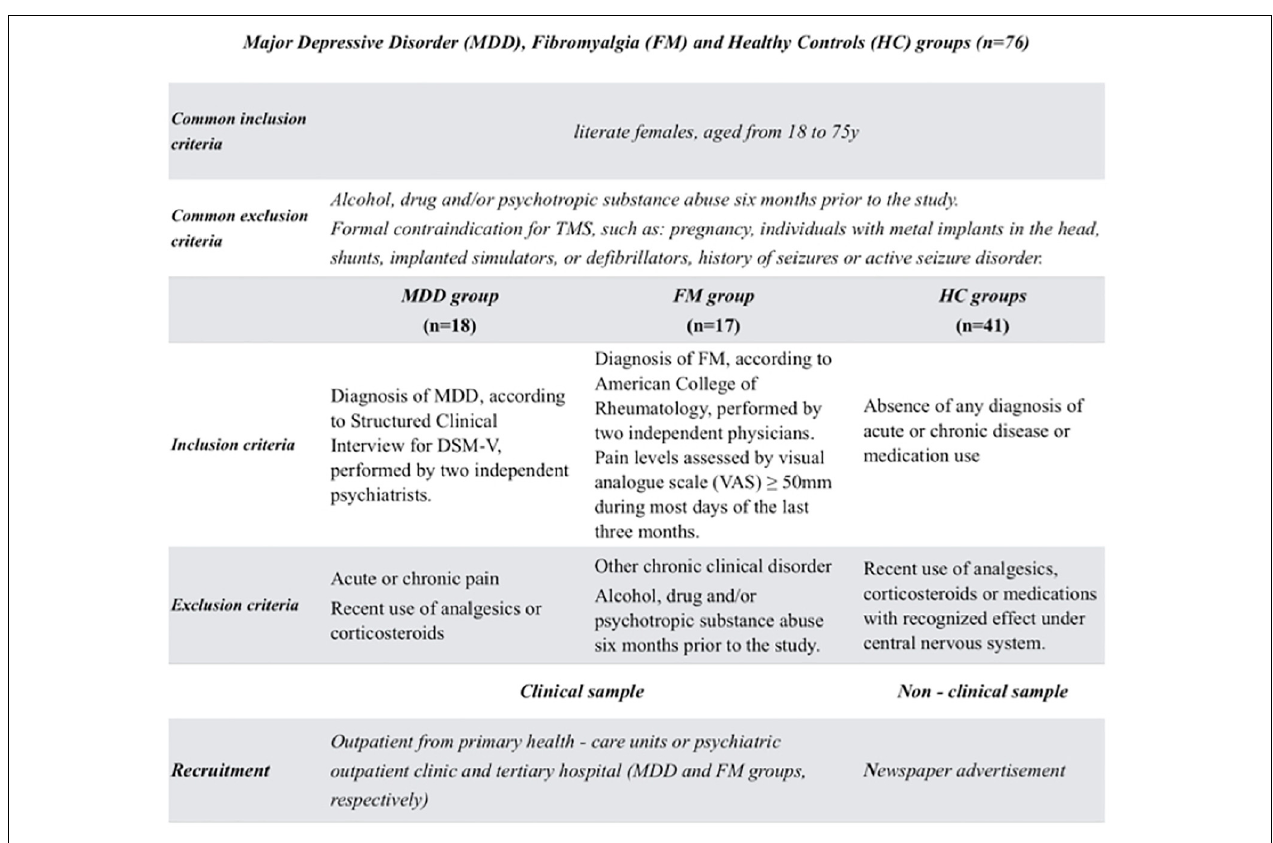
FIGURE 1 | The flow of the study with the inclusion and exclusion criteria of three groups: patients with depression or fibromyalgia and healthy subjects.